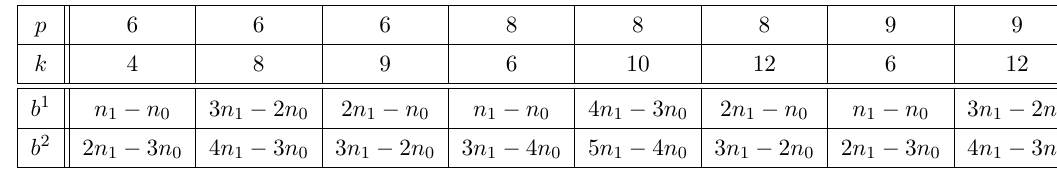
Table 5 . Mappings from ( n 0 , n 1 ) torsion flux numbers to ( b 1 , b 2 ) flux numbers. Here we give cases where k 6 = p for some c ∈ Z c